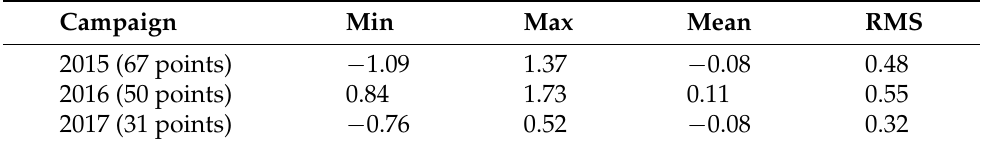
Table 2. Gravity differences at the crossover points onboard the research vessel DENEB (in 2015, 2016 and 2017) (unit: